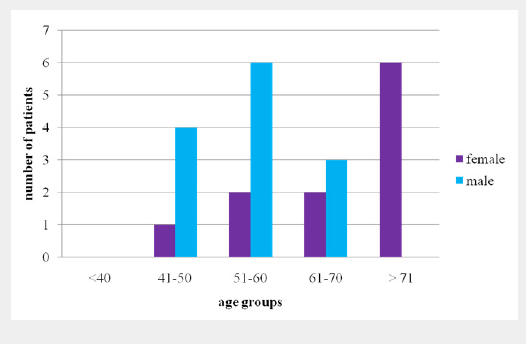
The distribution of the study population by age and gender. With increasing age, the amount of female participants increased, accounting for all of the participants in the age group >71